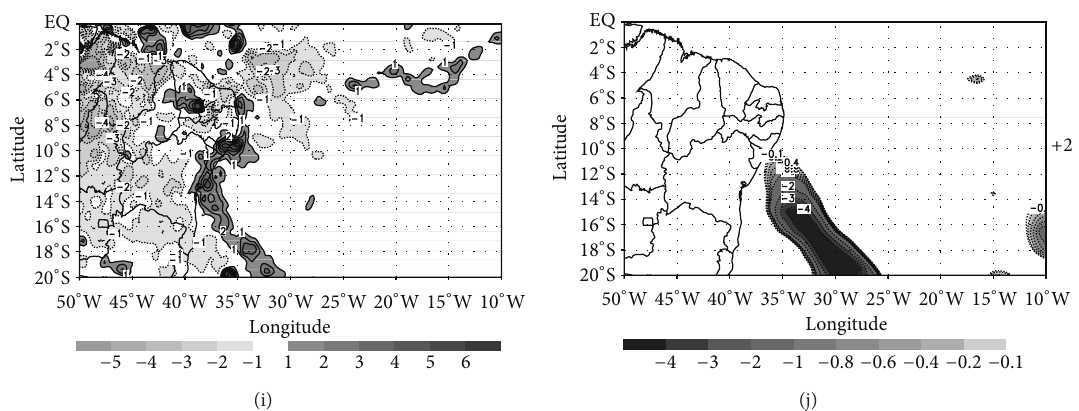
Figure 5: Precipitation (left column, mm ⋅ day −1 ) and outgoing longwave radiation (right column, W ⋅ m −2 ) composite anomalies in the period from April to July 2006.